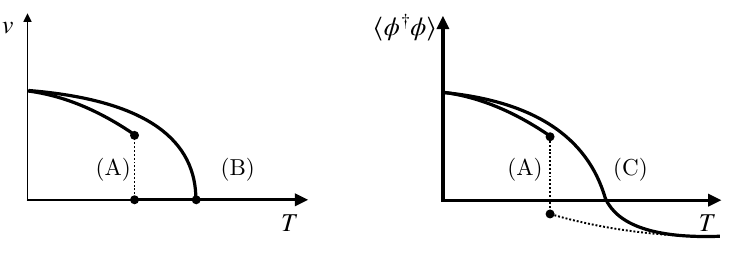
Figure 8 . Schematic illustration of order parameters in perturbation theory, as a function of temperature. Left: minimum of the effective potential ( v ) . At high T , v is zero, but non-zero at low T . If there is a discontinuity, the transition between the two phases is of first order (A). If v is continuous, but there is a discontinuity in the first derivative, the transition is of second order (B). A smooth crossover (C), where all order derivatives are continuous, is not possible. Furthermore, v itself is not a gauge invariant quantity. Right: the scalar condensate h φ † φ i has a non-vanishing value even in the high T phase, and hence a smooth interpolation between the two phases is possible, leading to a crossover between the phases. Condensates can be computed in a gauge invariant manner, even in perturbation